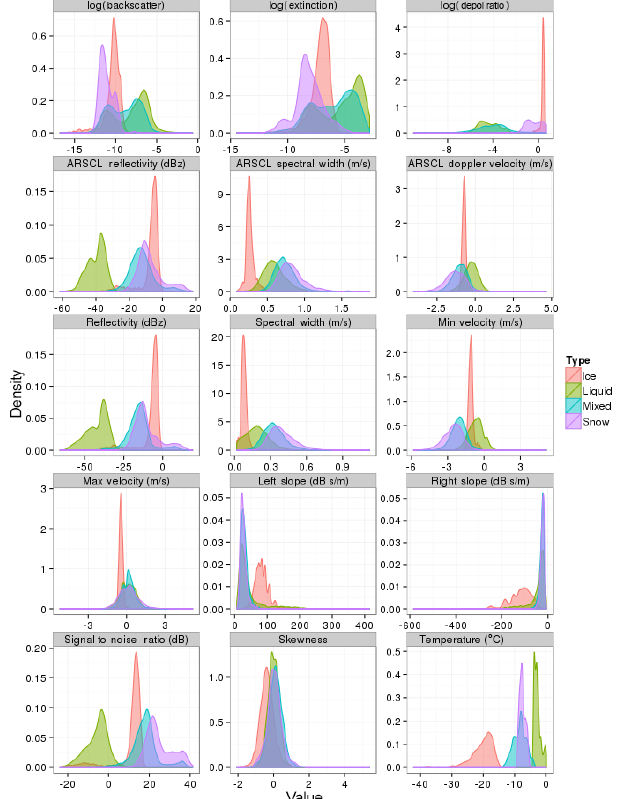
Figure 9. Histograms of algorithm training data set input variable values for four phase categories. Note that temperature is not in- cluded in the retrieval algorithm, but is included here for reference. Most clouds examined in this study are in the potentially mixed- phase temperature range ( − 40–0 ◦